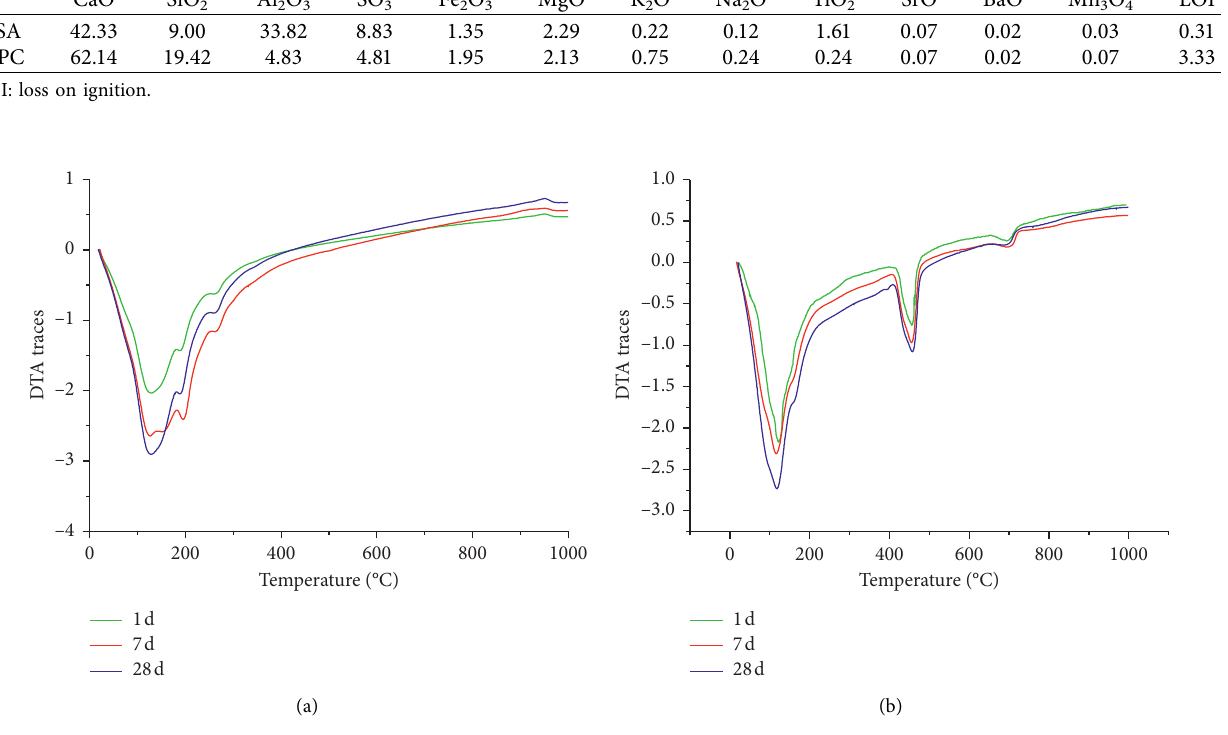
Figure 1: STA results of hydrated (a) CSA cement paste and (b) OPC paste cured at 21 ° C for 1d, 7 d, and 28d.